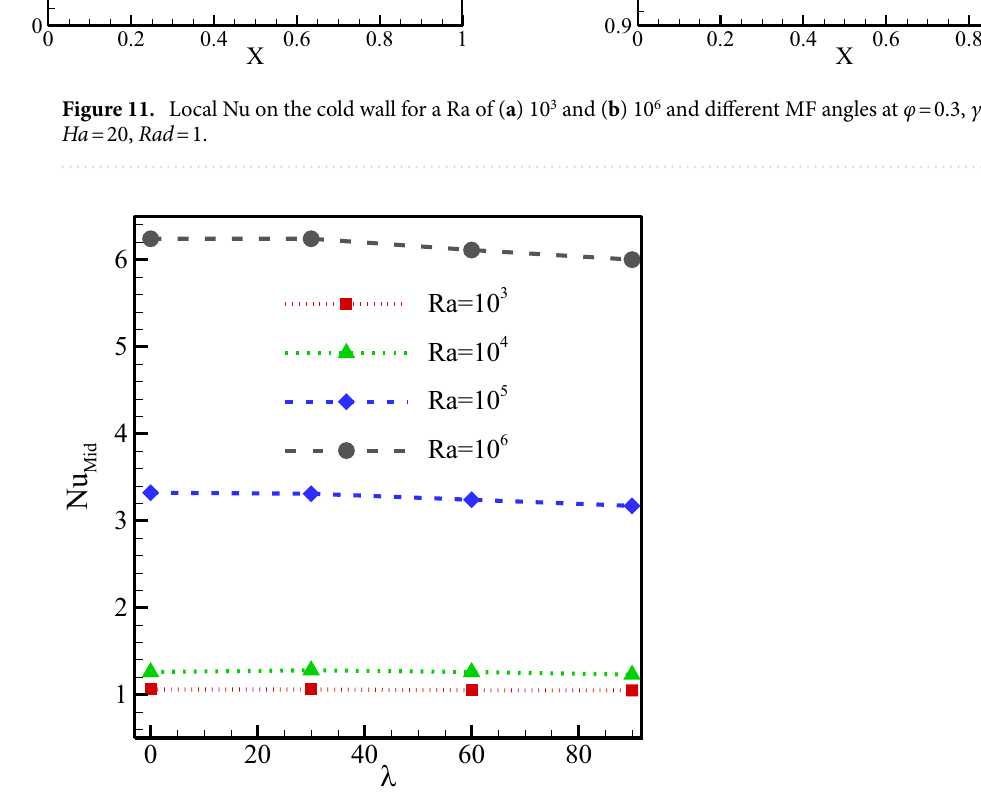
Figure 12. Average Nu for dissimilar Ra at φ = 0.3, γ = 45°, Ha = 20, Rad =